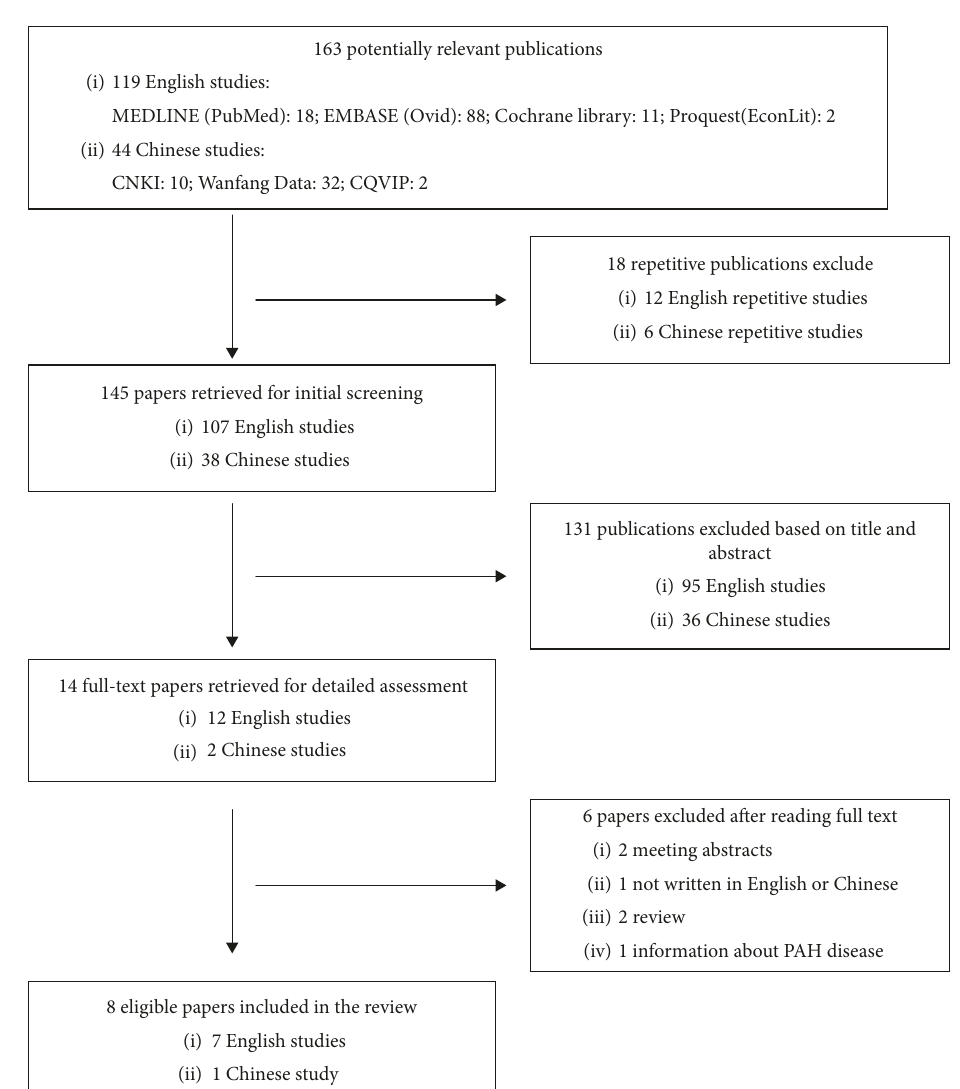
Figure 1: Flowchart of literature search. CNKI China National Knowledge Infrastructure database, CQVIP Chongqing VIP database, and PAH pulmonary arterial